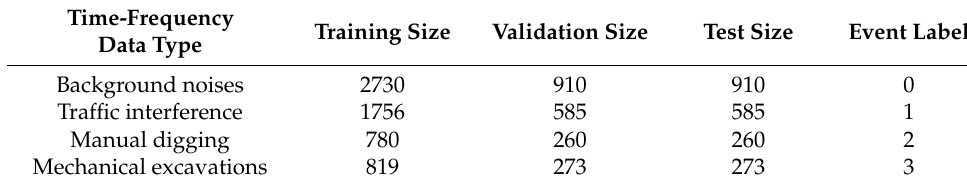
Figure 4. Field scenes, typical signals, and STFT pseudo-color RGB time-frequency diagrams of ( a ) background noise; ( b ) traffic interferences; ( c ) manual diggings; and ( d ) mechanical excavations. Table 2. The database of the buried urban communication cable